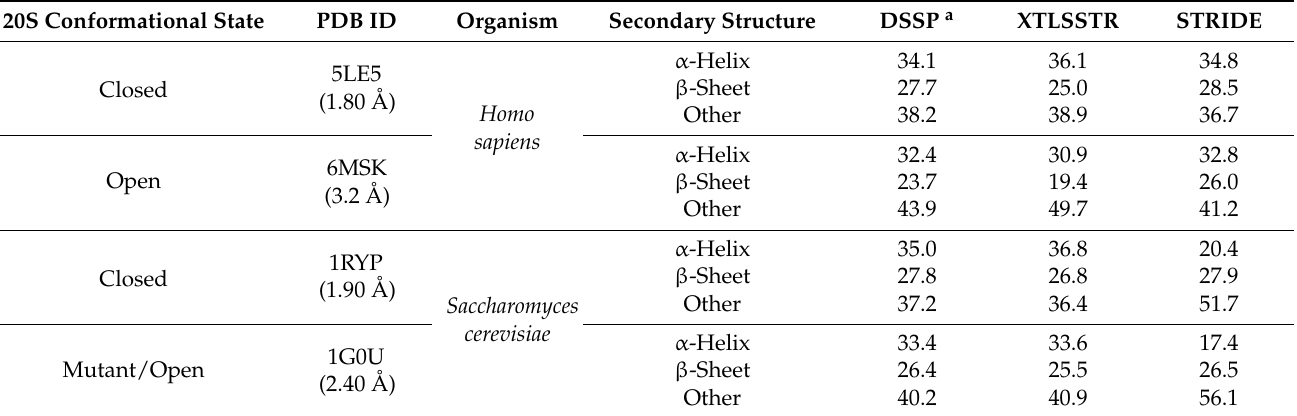
Table 1. Relative content of secondary structures (percentages) based on analysis of the experimentally determined structures of h20S and y20S proteasome in the closed and open conformational states.